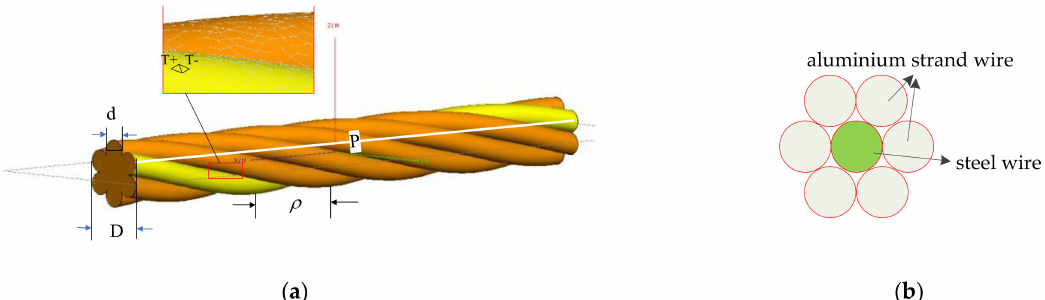
Figure 6. Simulated power line with a steel core and six outer aluminum stranded wires. ( a ) The surface of the power line. ( b ) The cross-section of the power line.